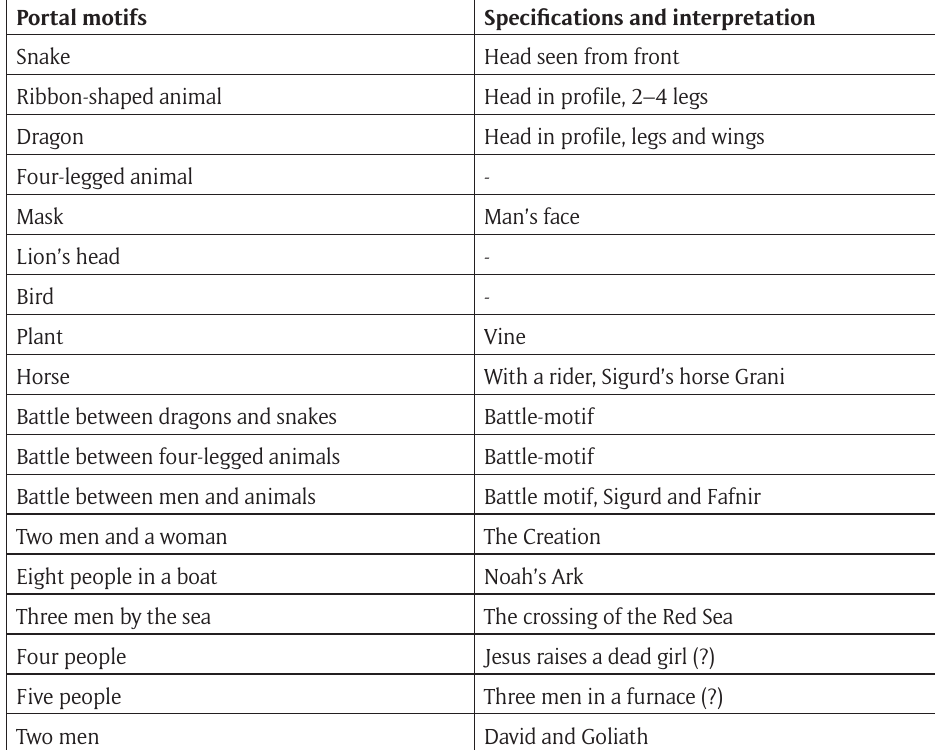
Table 2: Identified motifs from the six analysed portals. The question marks indicate an un- certain interpretation based on literary Table 3 presents three categories: motifs